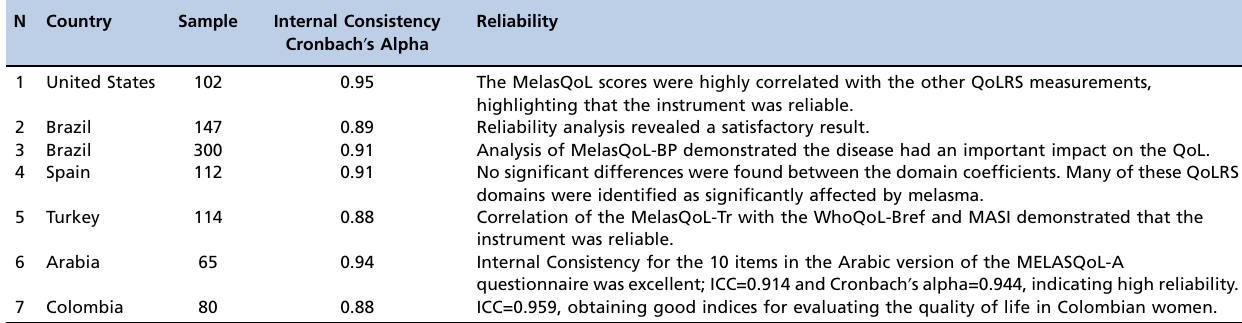
Table 2 - Publications in relation to validation and transcultural adaptation works of MelasQoL. Botucatu, SP, Brazil, 2015. N Country Sample Internal Consistency Cronbach ’ s Alpha